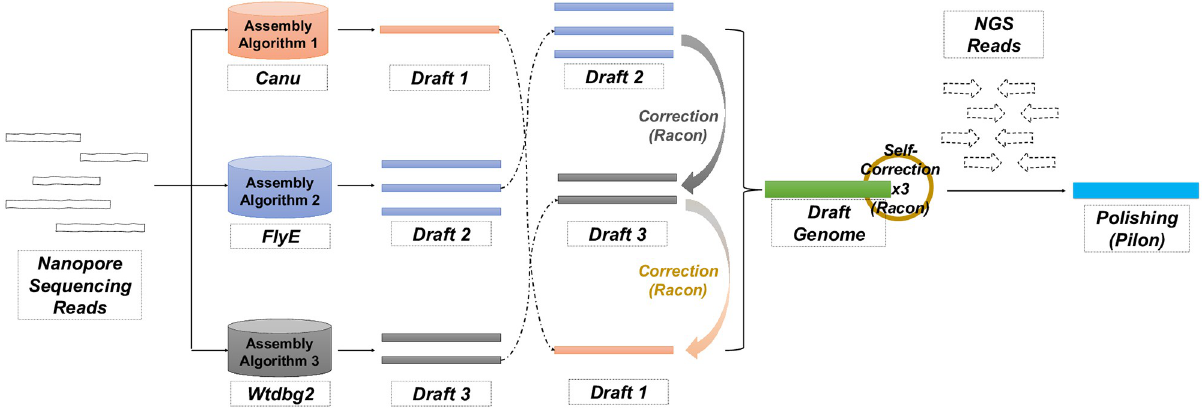
Fig 1. Overview of the MAECI assembly